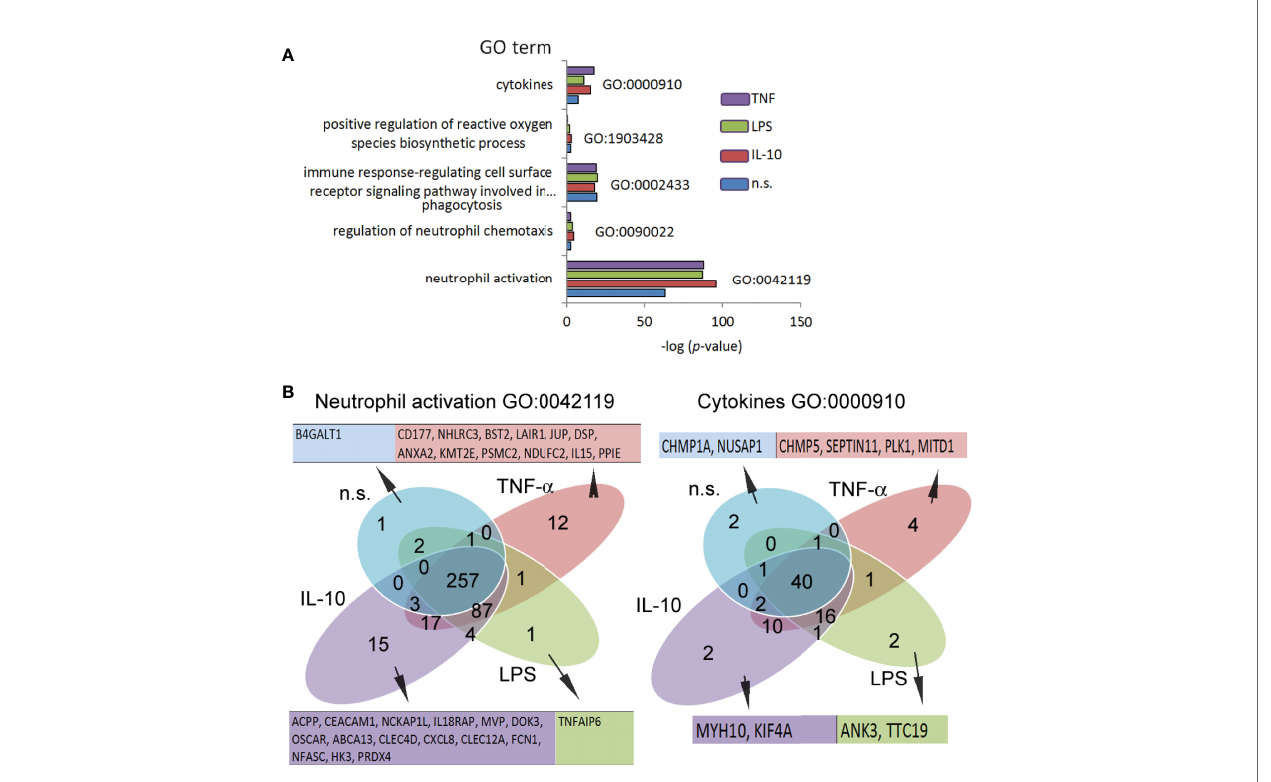
FIGURE 5 | Neutrophils stimulated by IL-10, LPS, or TNF- a regulated H3K4me3-marked histone gene pro fi le, determined different effects they exert during in fl ammation. (A) Gene Ontology analysis of the main processes responsible for neutrophil properties. Graph represents mean value calculated from four independent experiments. (B) Binding site overlap in the GO term ‘ neutrophils activation ’ and ‘ cytokines ’ ; n.s,